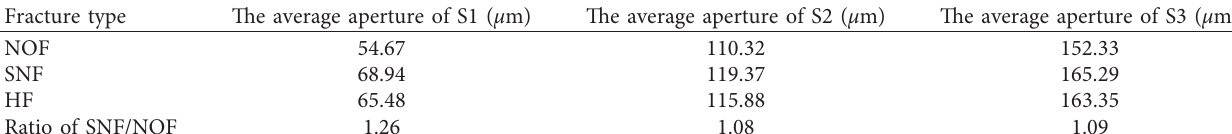
Table 3: Aperture of fractures on the surfaces of specimens.